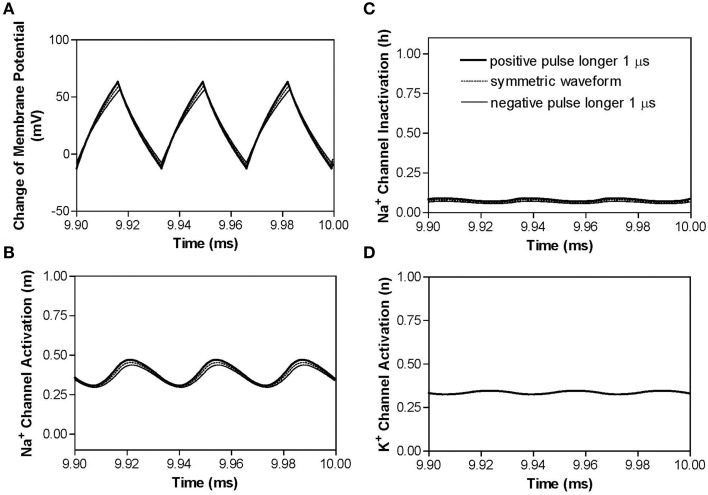
The effects of non-symmetric waveforms on membrane potential and activation/inactivation of ion channels under the block electrode when stimulation frequency is 30 kHz. The legends in (C) indicate the types of waveforms: symmetric and non-symmetric with a 1 μs difference in pulse width between the positive and negative pulses. (A) Change of membrane potential, (B) Na+ channel activation, (C) Na+ channel inactivation, (D) K+ channel activation. Stimulation waveforms: 30 kHz at block threshold intensities. Axon diameter: 2 μm. Abscissa: time in ms after the start of blocking stimulation.